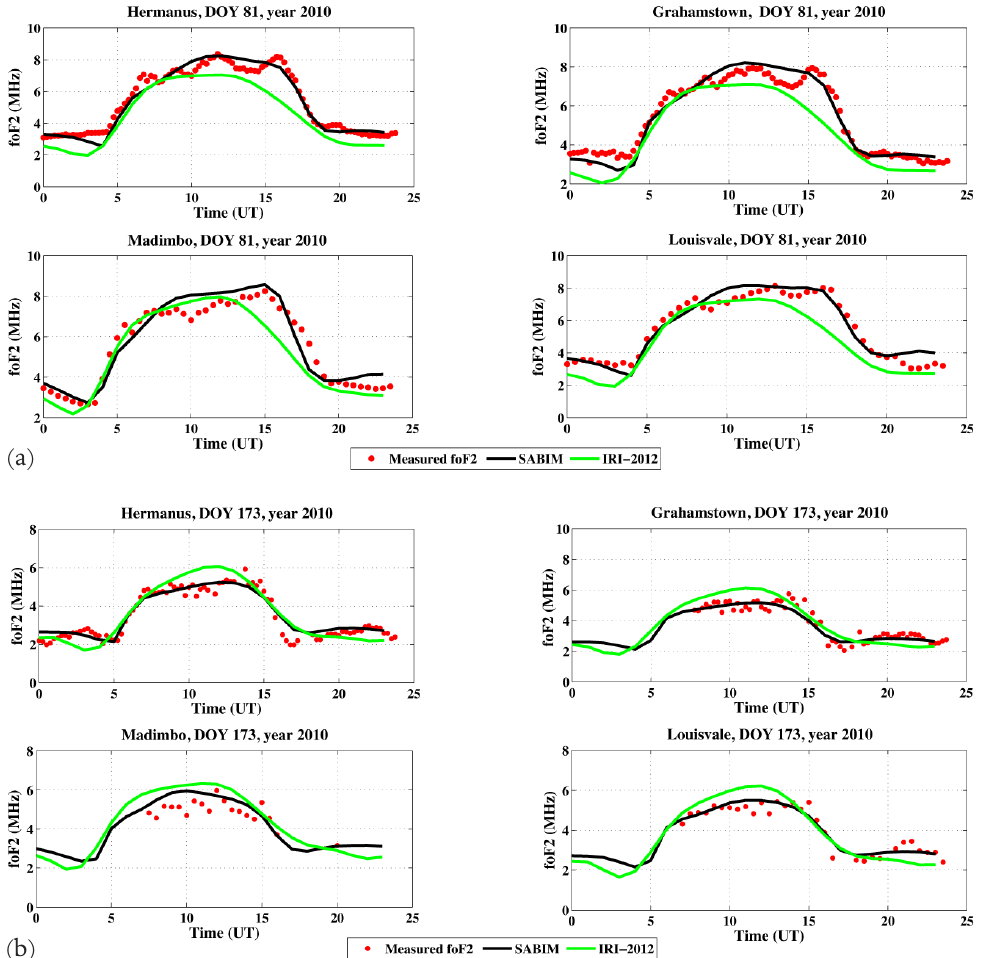
Figure 2. A comparison of diurnal foF2 values from the SABIM model, the IRI-2012 model and the ionosondes (Hermanus, Grahamstown, Louisvale and Madimbo). (a) Equinox in March (Day of Year (DOY) 81) 2010, and (b) solstice in June (DOY 173) 2010.